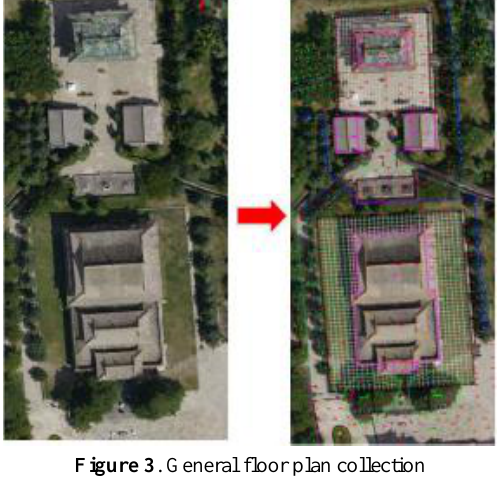
Figure 3 . General floor plan collection